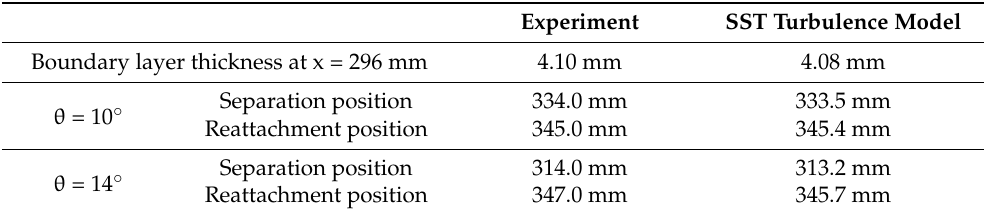
Figure 5. Flow structure on the symmetry plane for θ = 14 ◦ case. ( a ) Mach number contour; ( b ) density gradient contour. Table 3. Comparison of the boundary layer thickness and the position of separation and reattachment between the experiment and simulation.